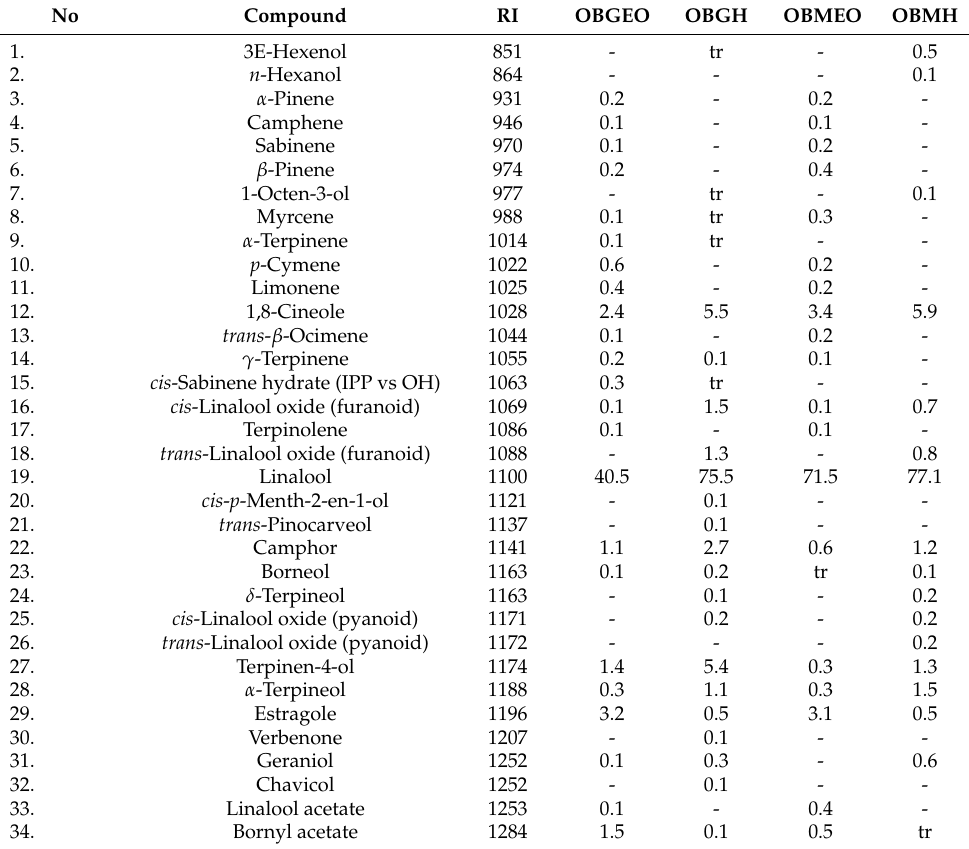
Table 1. Chemical composition of O. basilicum essential oils and